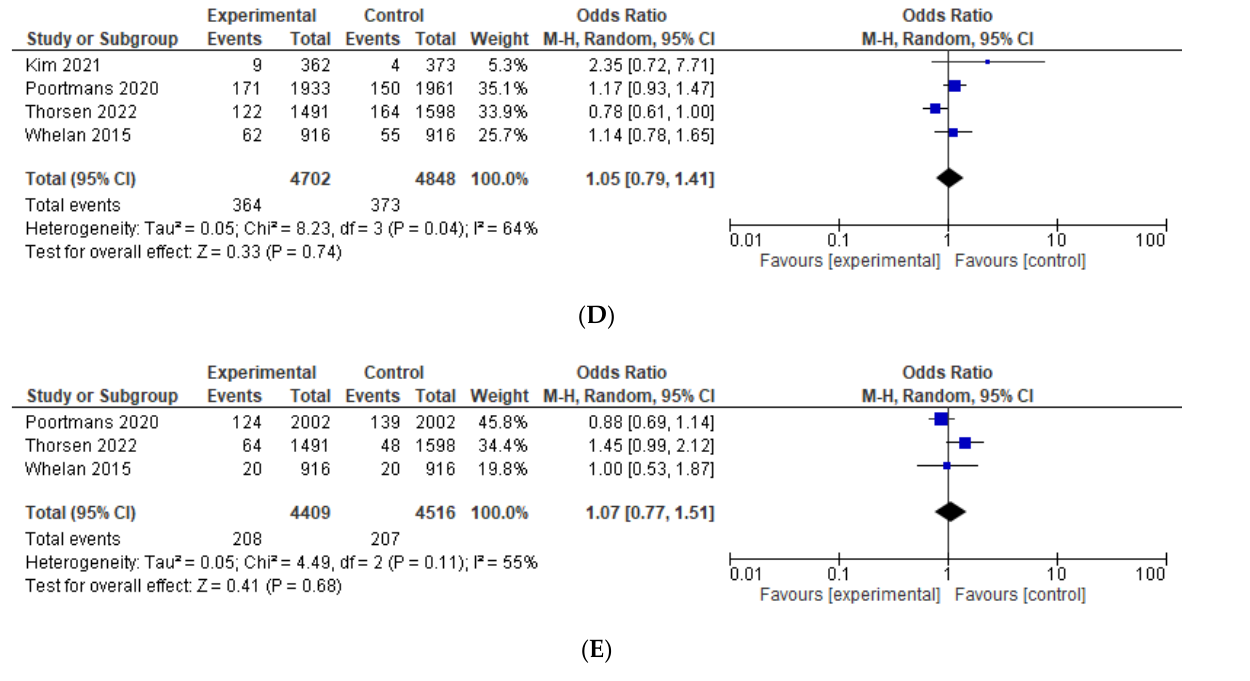
Table 4. The results of the meta-regression for